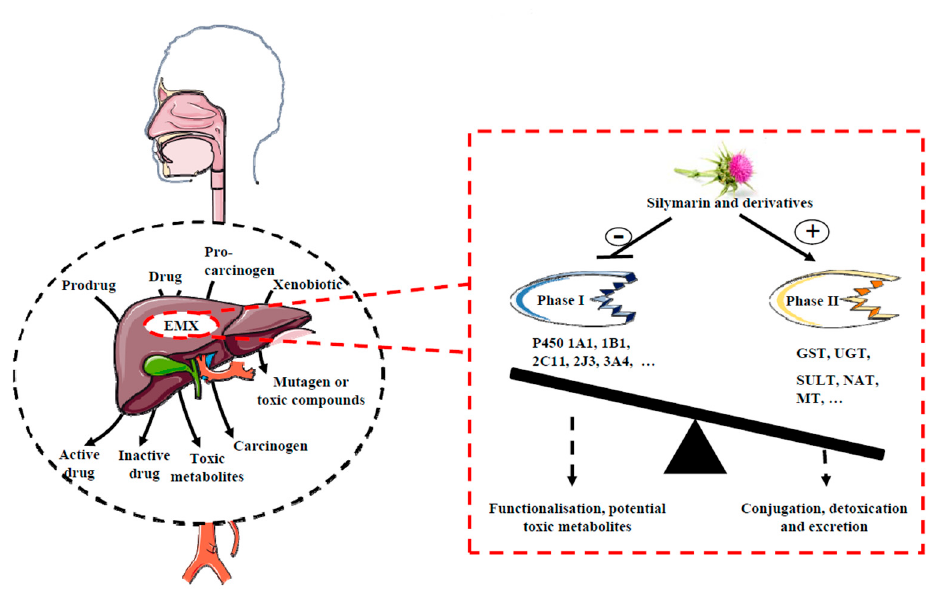
Figure 2. Effect of silymarin on phase I and phase II enzymes. Xenobiotics metabolizing enzymes (XME) biotransform various molecules such as prodrug, drug, procarcinogens, xenobiotics into active drug, inactive drug toxic metabolites, carcinogen and mutagen/toxic metabolites. Silymarin and derivatives may decrease the activity of phase I enzymes (i.e., P450) and activate phase II enzymes to increase the detoxication process. By these properties, silymarin and its derivatives may act as a chemopreventive or an adjuvant to decrease in normal cells toxicity-induced by chemotherapeutic agents.